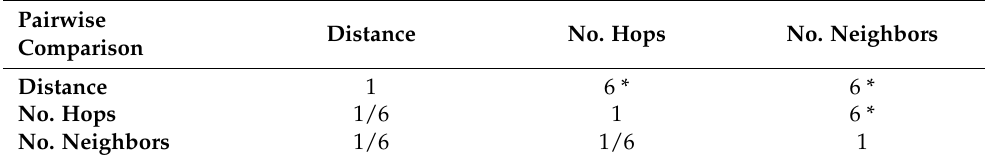
Table 4. Pairwise comparison matrix of criteria.